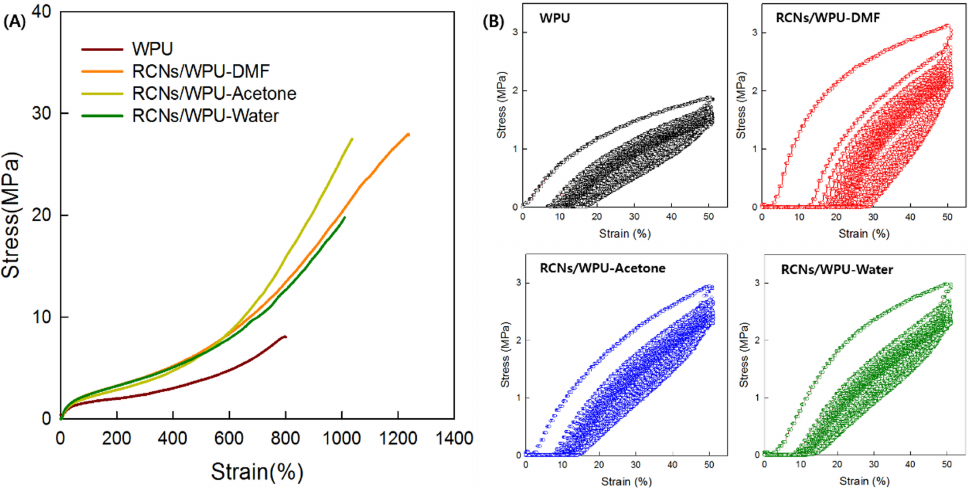
Figure 5. ( A ) Stress–strain, Young’s moduli (inset) and ( B ) Tensile recovery properties curves of WPU, RCNs/WPU nanocomposites